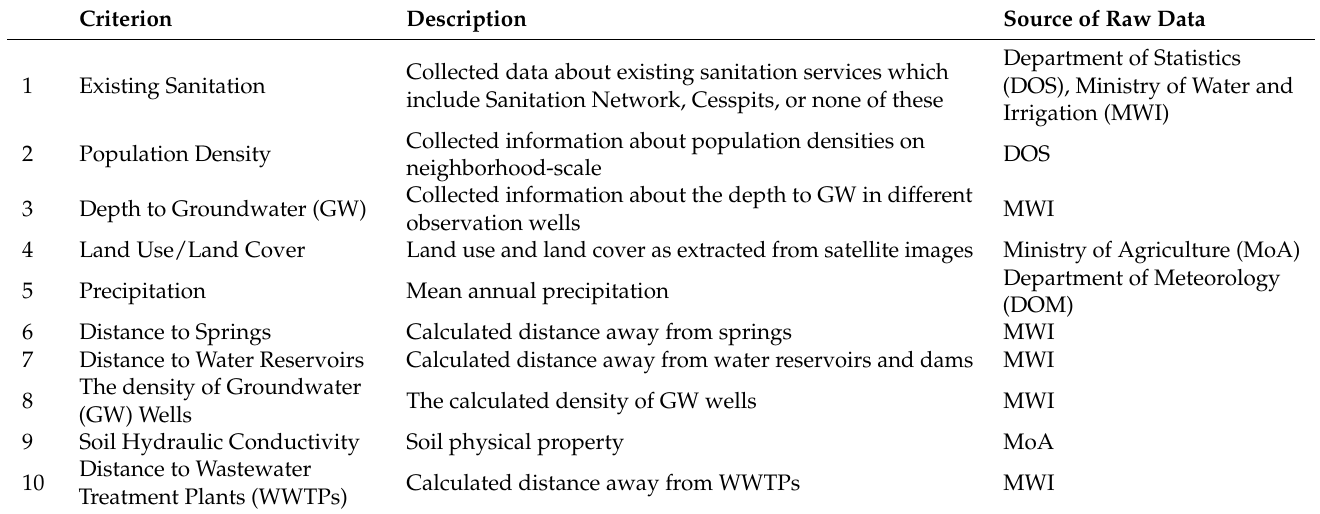
Table 1. List the selected criteria for sanitation hotspot mapping based on experts’ and stakehold- ers’